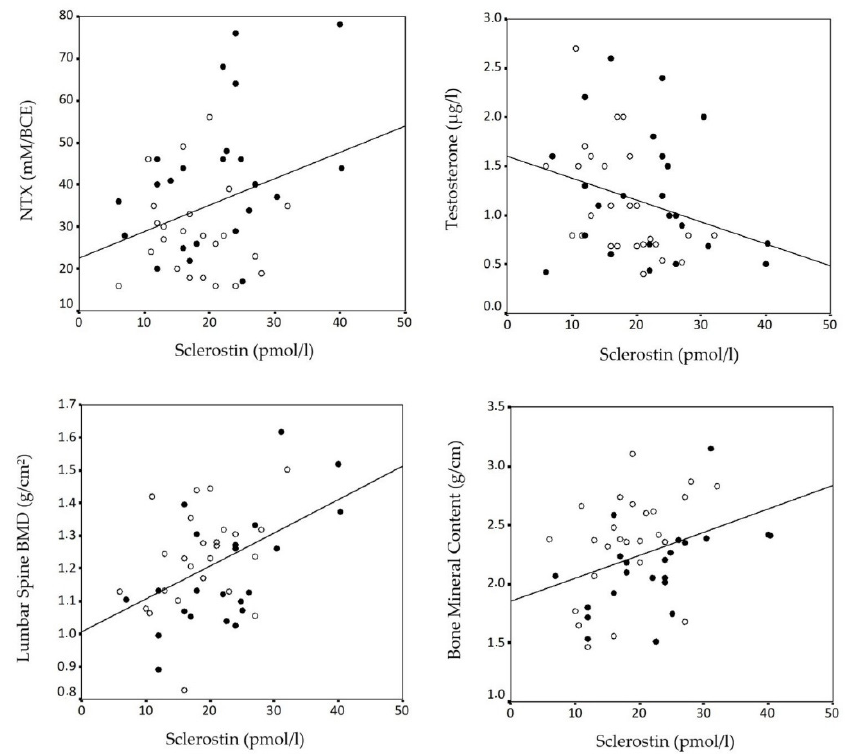
Figure 1. Bivariate correlation analysis between sclerostin levels (pmol/L) and NTX levels (mM/BCE), testosterone levels ( µ g/L), Lumbar Spine BMD (g/cm 2 ) and BMC (g/cm) in premenopausal (open circles) and postmenopausal obese women (closed circles).